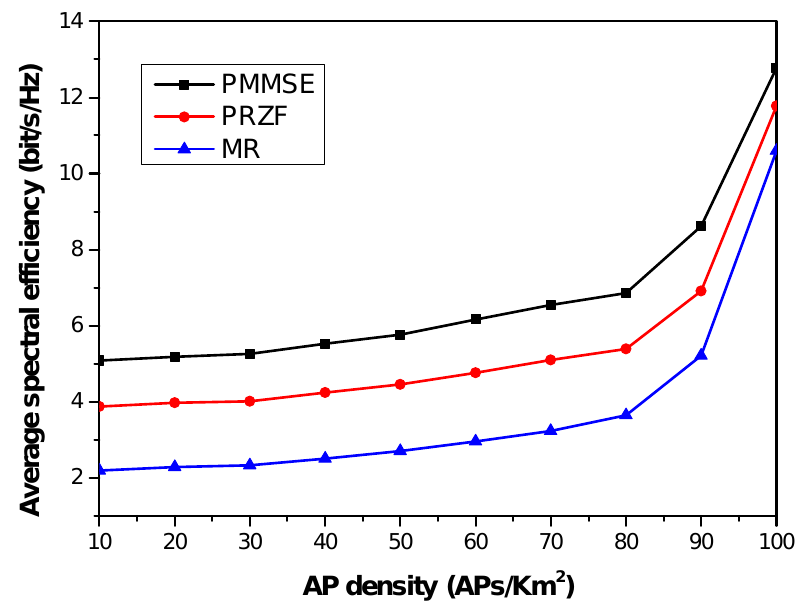
Figure 2. Spectral efficiency as a function of AP density for different receive combiners.